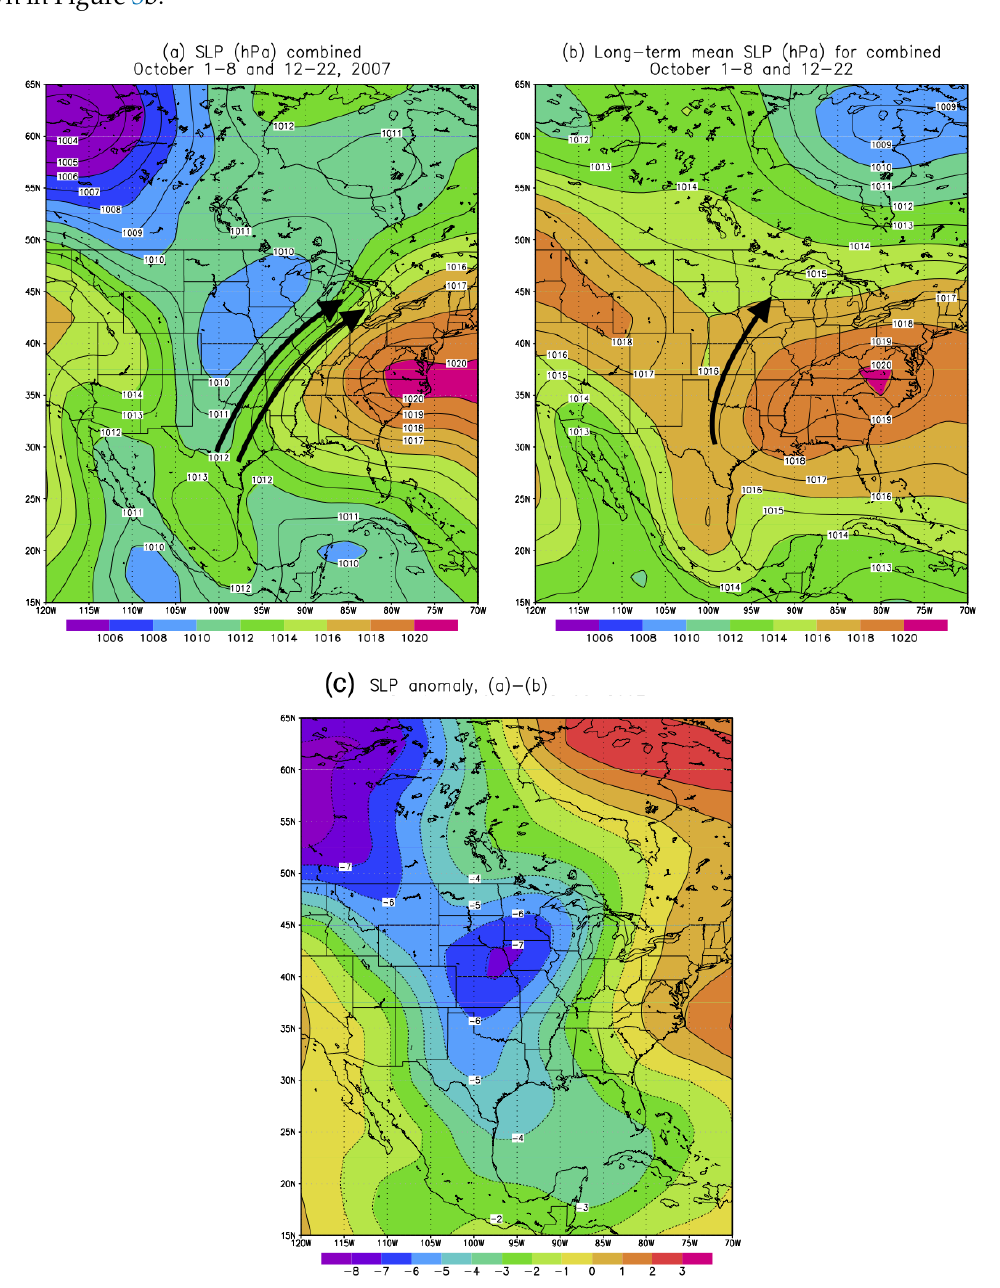
Figure 5. Same as Figure 4 except for the sea level pressure field in units of hPa. The dark black lines with arrow highlight the dominant wind in ( a , b